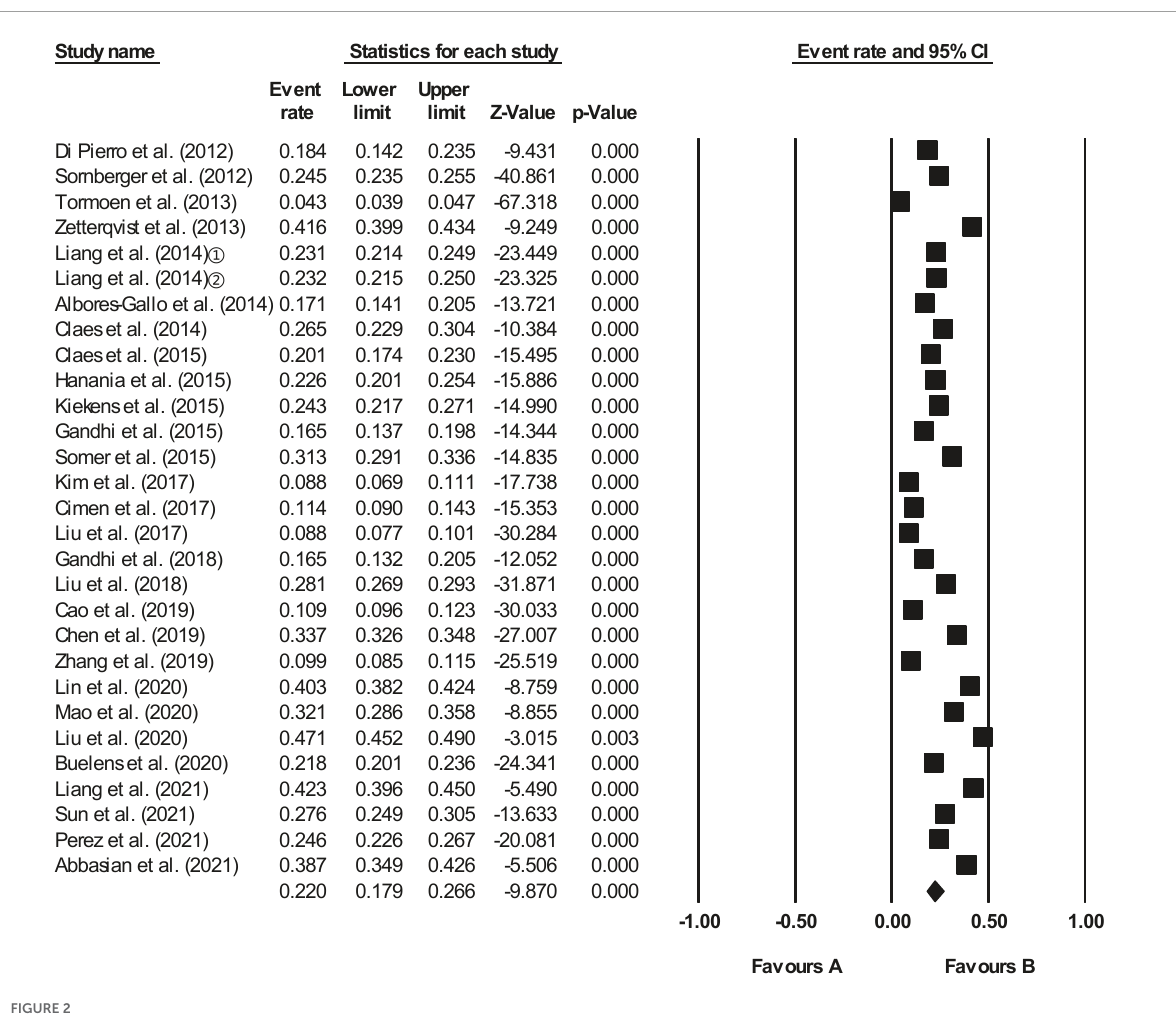
FIGURE2 Forest plot of the lifetime aggregate prevalence of non-suicidal self-injury (NSSI) in adolescents. The location of the square represents the incidence of the event, the size of the square represents the weight, and the diamond represents the combined